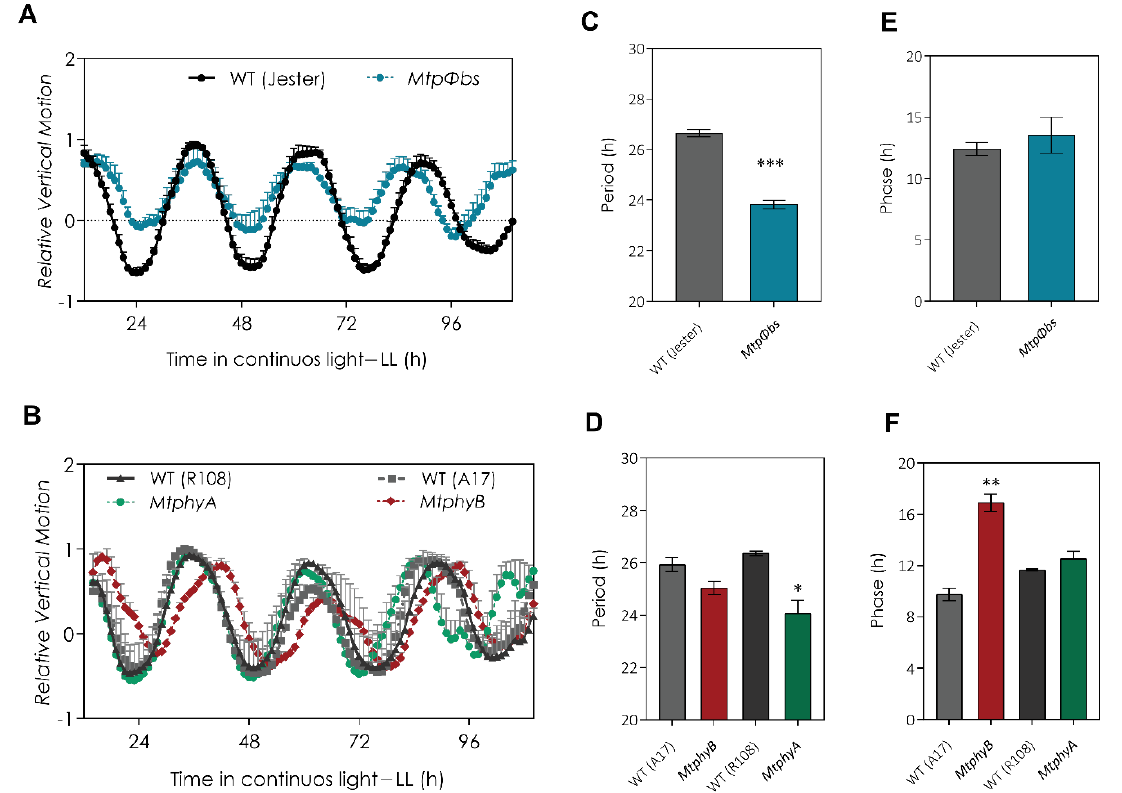
Figure 5. The Mtp Φ bs mutant has an altered circadian clock, and it is shared with the MtphyA mutant. Circadian rhythm of cotyledon movement was recorded in plants entrained under long-day conditions (16 h light/8 h darkness) and then transferred to constant light (LL) for 5 days. Relative vertical motion was obtained for ( A ) WT (Jester); black circles, MtpΦbs mutant blue circles; ( B ) WT (R108); black triangle; MtphyA green circles; WT (A17) grey squares and MtphyB, red circles. n = 4 for all genotypes. ( C , D ) Period length of cotyledon movement estimated by fast Fourier transform – nonlinear least test (FFT-NLLS). ( E , F ) Phase of cotyledon movement. Error bars represent SEM. * p < 0.05, ** p < 0.01, *** p < 0.001 (Student t -test). h = hours.